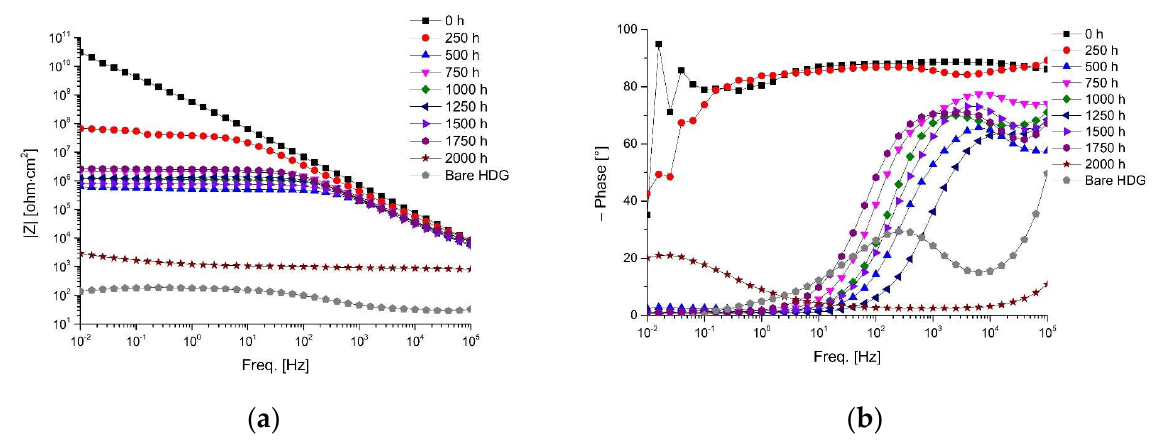
Figure 2. Example of impedance modulus ( a ) and phase angle ( b ) evolution in time for painted HDG steel during NSST.